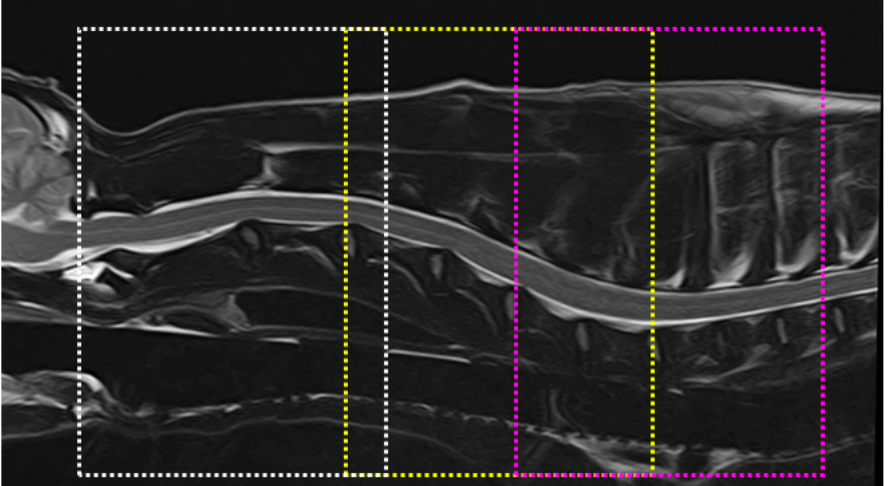
Figure 1. Transverse diffusion tensor images acquired using three overlapping slabs in T2-weighted images in the sagittal plane to cover the C1-C4 (white line box), C4-C7 (yellow line box), and C6-T2 vertebrae (pink line box).